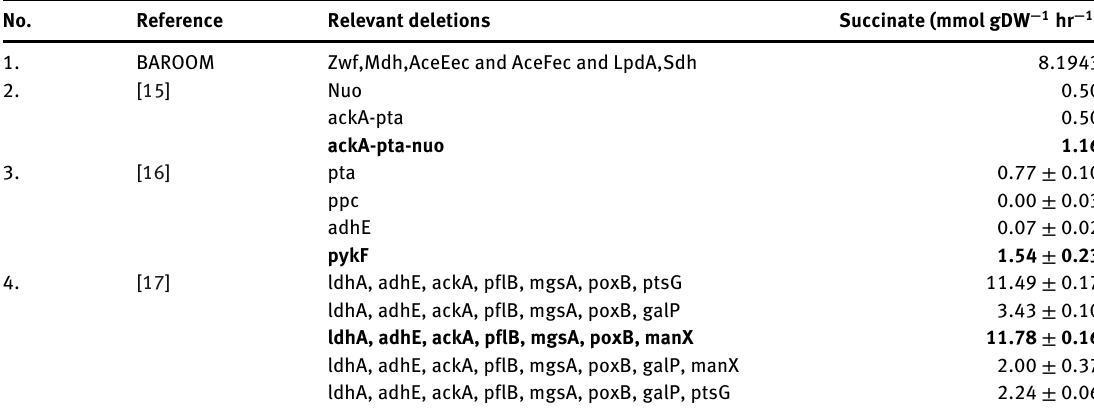
Table 4: Succinate production for the engineered strain in E. coli